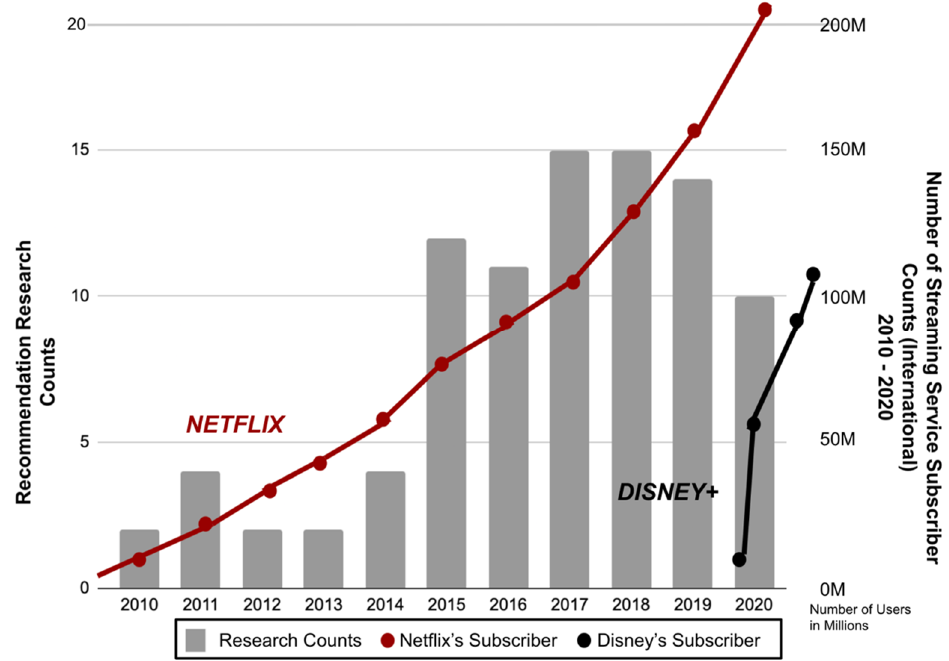
Figure 23. Trends in streaming service field research from 2010 to 2021 and the number of users of Netflix and Disney, the representative streaming service types.